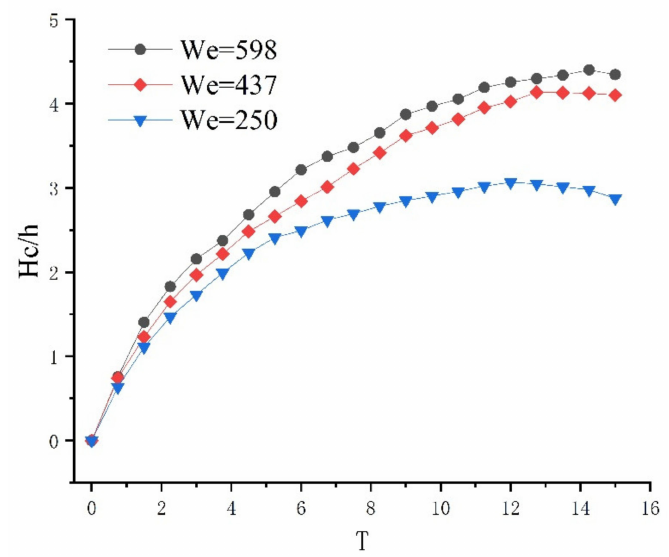
Figure 7. The dimensionless crown height changing with dimensionless time under three different Weber numbers.